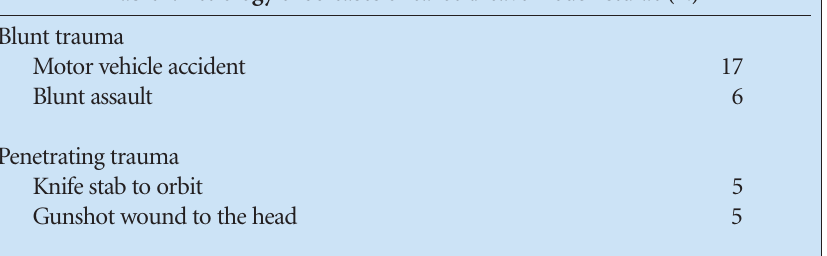
Table I.Aetiology of 33 cases of carotid-cavernous fistulae ( N )